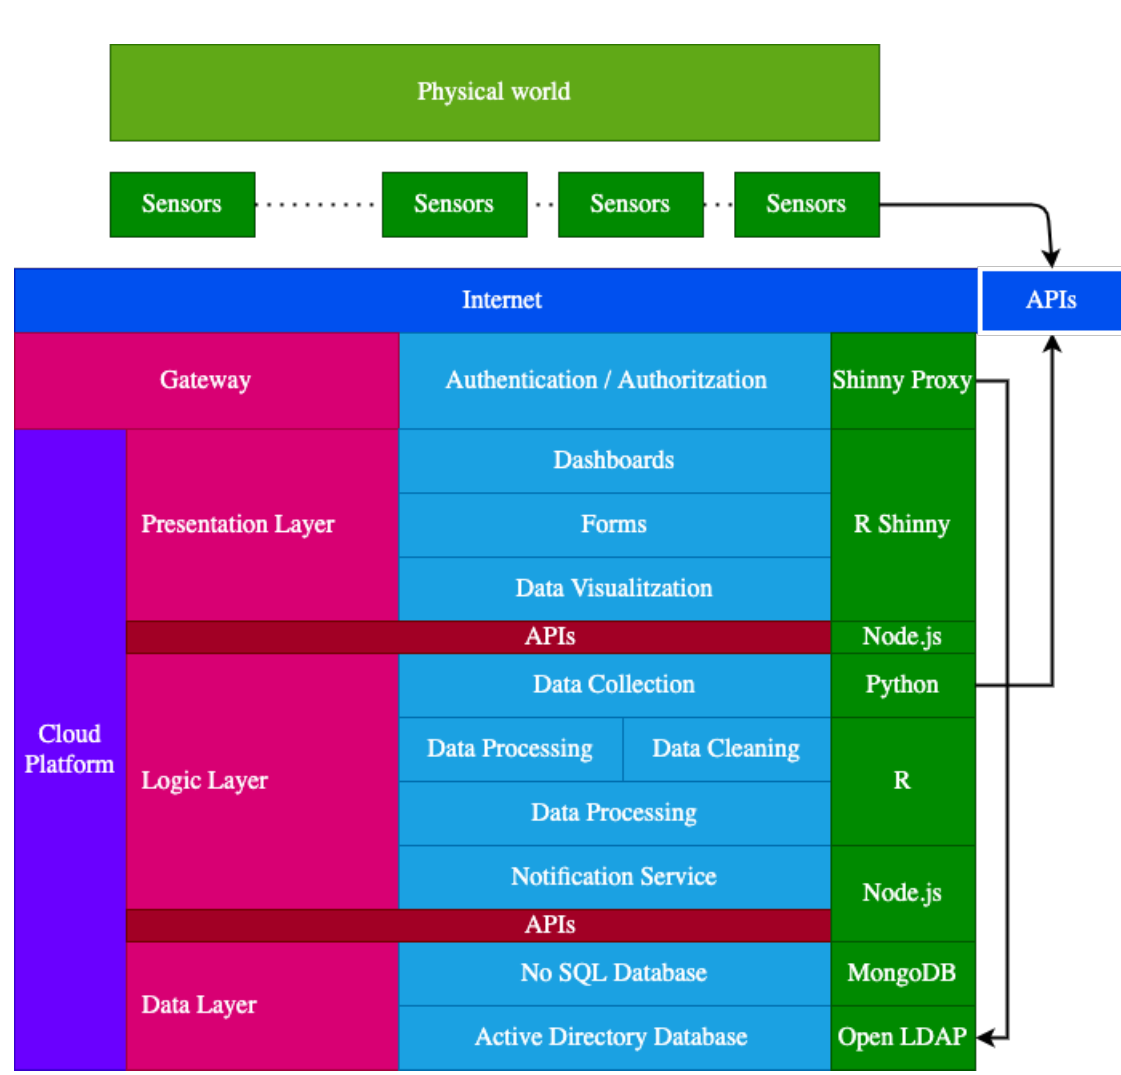
Figure 2. Cloud architecture